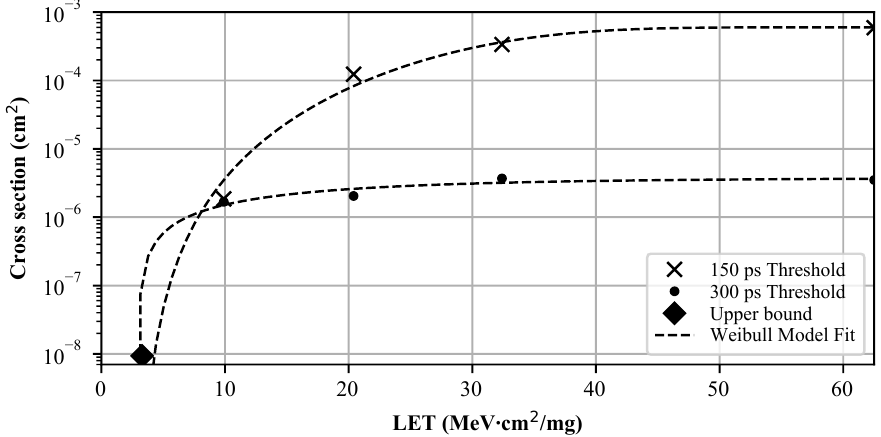
Figure 10. Experimental heavy ion cross-section for different phase excursion thresholds.